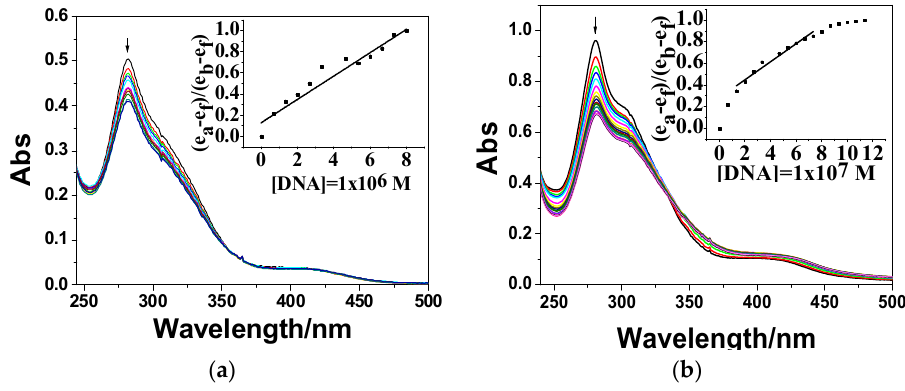
Figure 3. The electronic absorption spectra of complex 1b interacted with ( a ) calf thymus DNA (CT-DNA); and ( b ) bcl-2 G-quadruplex DNA. [Ru] = 20 μ mol, [CT-DNA] = 1 μ M, [ bcl-2 G4-DNA] = 100 μ M. The arrow shows the emission intensity changes upon increasing DNA concentration.